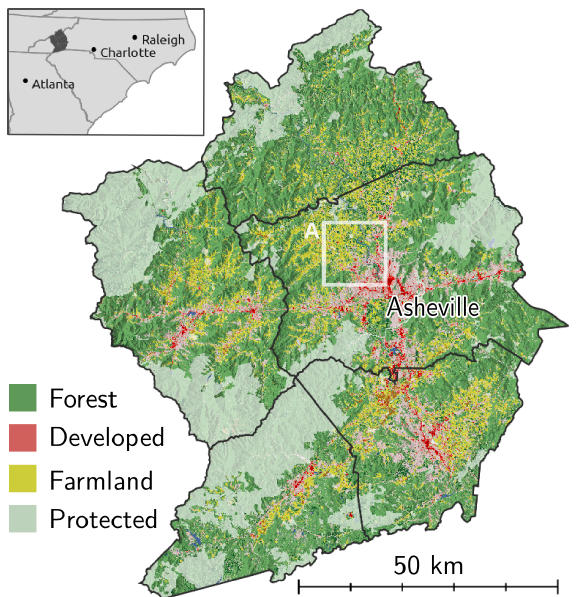
Figure 4: 2011 land cover (Homer et al., 2015) and protected areas (Anderson and Sheldon, 2011) in the Asheville metropolitan area in the west of North Carolina, USA. Inset A is used in Figure